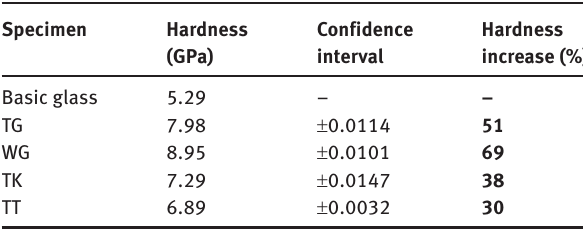
Table 3: Microhardness measurement results of glasses specimens Specimen